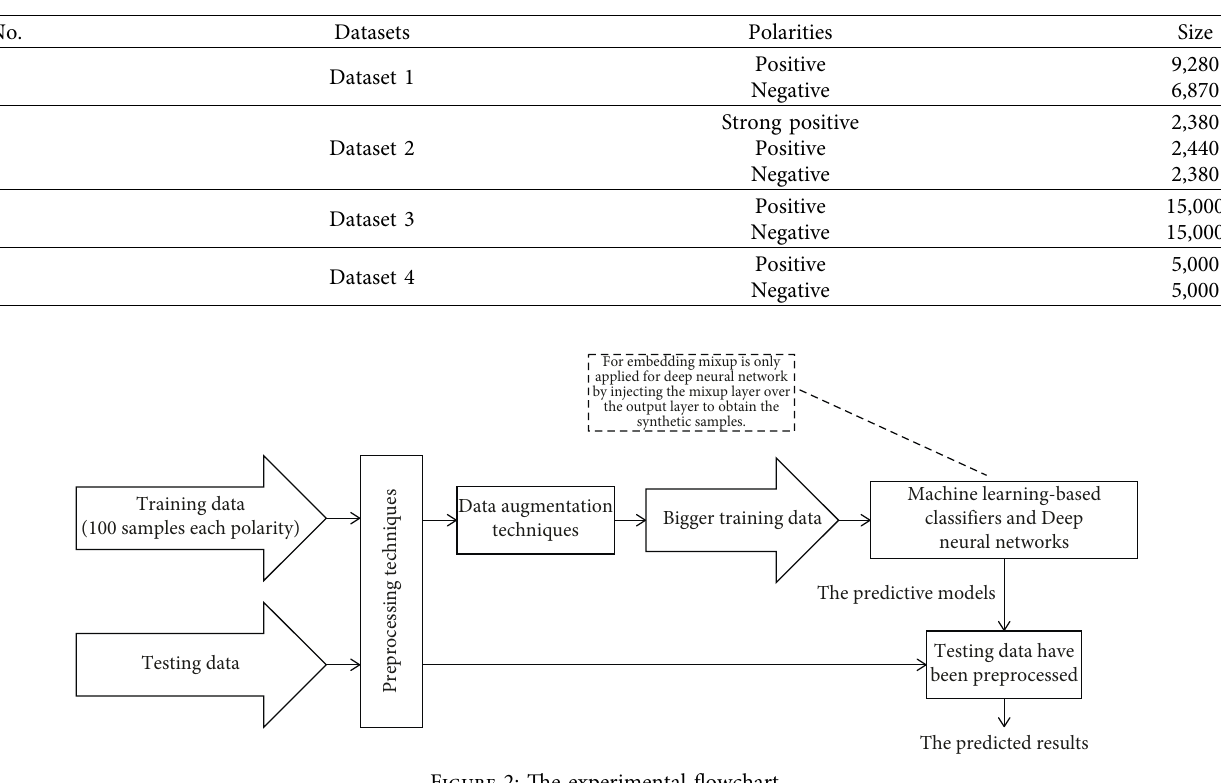
Figure 2: The experimental flowchart. Table 2: The accuracy results of various preprocessing techniques for Vietnamese sentiment analysis based on machine learning classifiers. Datasets